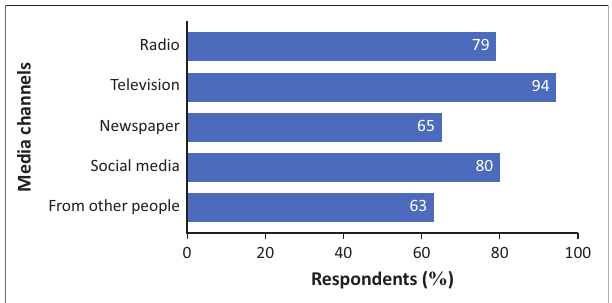
FIGURE 3: Media channels where respondents obtain coronavirus disease 2019 information.